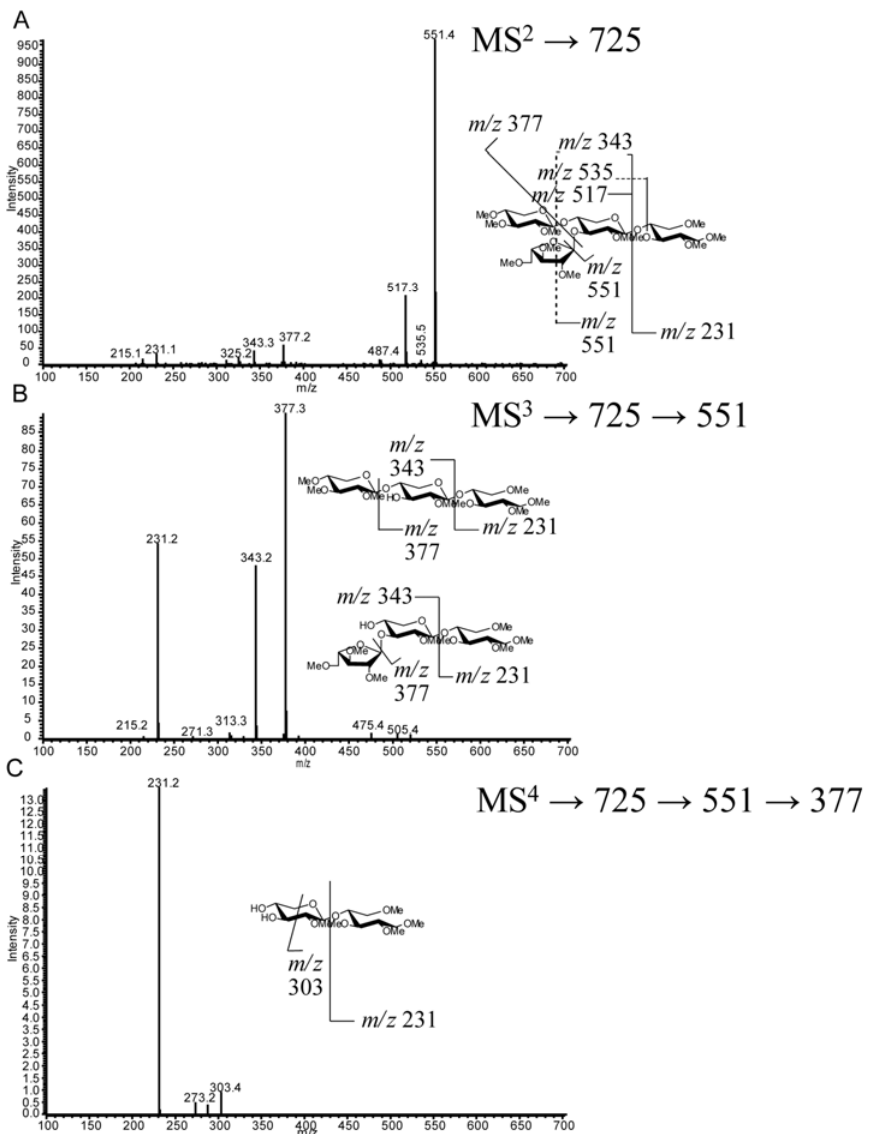
Figure 5. Mass spectrometry (MS n ) fragmentation of permethylated oligosaccharide VI (RT 23.5 min) ( a ) MS 2 m/z 725. ( b ) MS 3 fragmentation m/z 725 → 551. ( c ) MS 4 fragmentation m/z 725 → 551 →